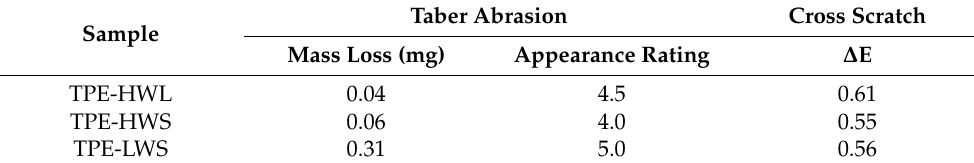
Table 9. Abrasion resistance of TPE prepared by SEBS with various molecular structures.